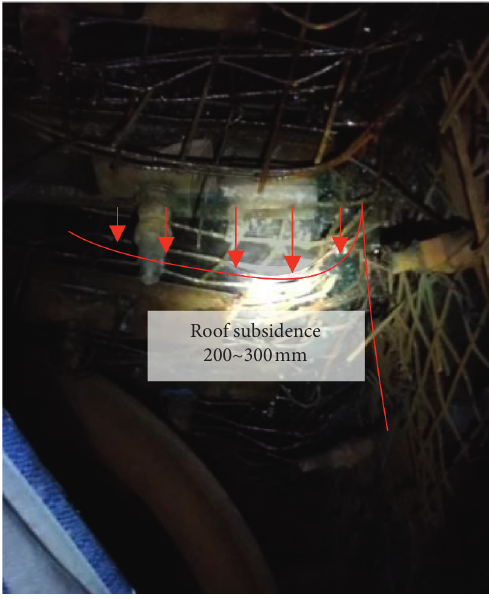
Figure 12: Drawing of roof subsidence at the right shoulder of the roadway.